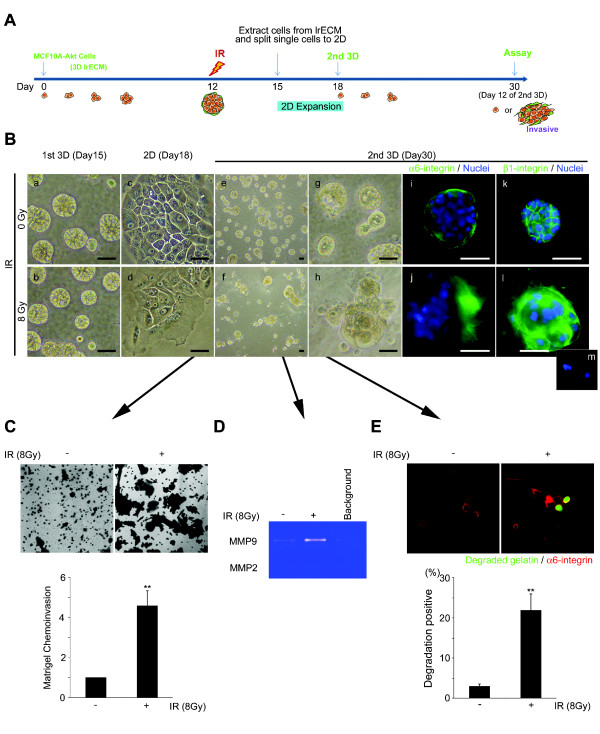
An invasive phenotype emerged from a sub-population of cells surviving post-IR in three-dimensional lrECM. (A) Experimental schema of the recurrence model. At Day 12, cultures were exposed to Sham or 8 Gy IR. On Day 15, the colonies were taken out of three-dimensional lrECM, dissociated to make single cells, and expanded on two dimensional. Single cells were re-plated on three-dimensional lrECM and propagated until Day 30 (12 additional days). (B) Phase-contrast micrographs show that a distinct phenotype emerged by Day 30 of culture. Bar = 50 μm. IF images show α6-integrin or β1-integrin (green). Bar = 50 μm. (C) Invasive activity of MCF10A-Akt cells post-IR was quantified using invasion chambers. Graphical representation of the invasive cell numbers were normalized with control, non-irradiated cultures (n = 3; **, P < 0.01). (D) Gelatin zymography shows that MMP-9 secretion was increased in culture medium of IR-treated MCF10A-Akt. (E) Matrix degradation activity was confirmed by fluorescently labeled DQ-gelatin matrix. Degraded gelatin is shown in green (22% ± 7 invasive cells versus 3% ± 1; n = 3; **, P < 0.01). DCIS, ductal carcinoma in situ; IF, immunofluorescence; IR, ionizing radiation; lrECM, laminin-rich extracellular matrix; MMP-9, matrix metalloproteinase-9.